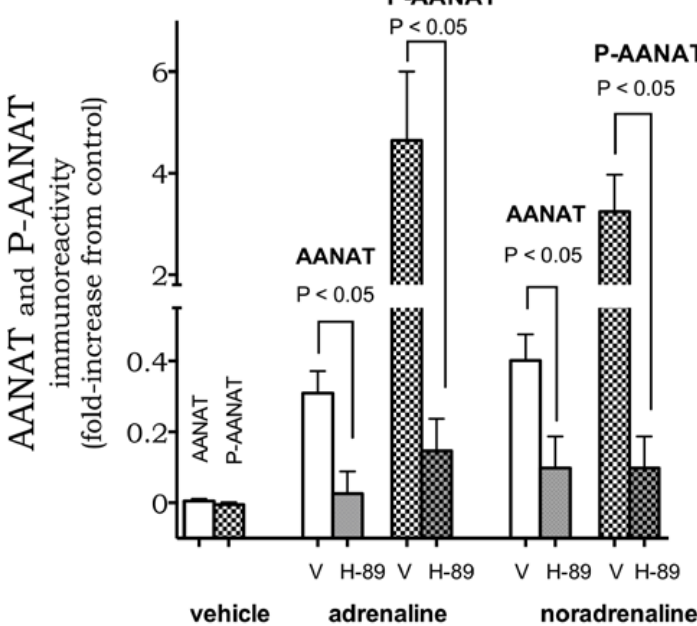
Figure 4. PKA activity modulates AANAT and P-AANAT expression. PKA inhibitor H-89 (H, 100 nM, 30 min) inhibits adrenaline (0.4 nM) and noradrenaline (0.2 nM)-induced increase in AANAT (open bars) and P-AANAT (crosshatched) immunoreactivity. Data represent mean ± SEM of three to six independent experiments. V = vehicle (0.001% ethanol).